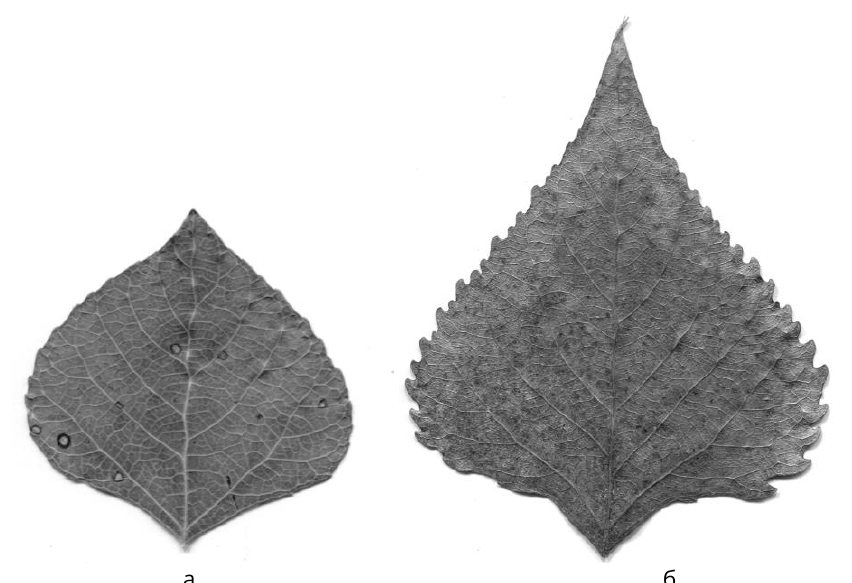
Рис. 1. Листовые пластинки Ро pulus nigra L . с минимальным и максимальным значениями показателями